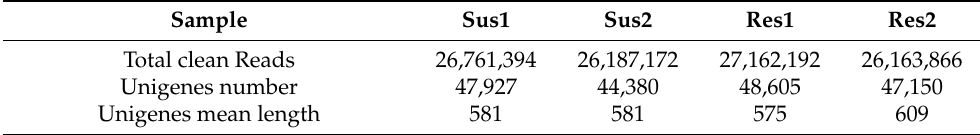
Table 3. Summary of Illumina transcriptome sequencing and assembly for the onion